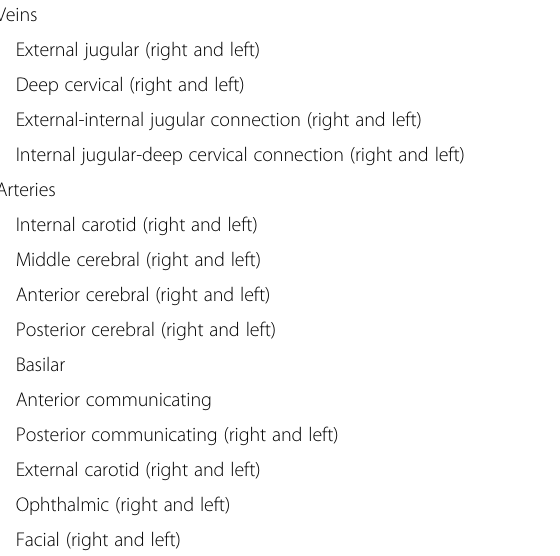
Table 3 Vessels added in the present adjustment of the mathematical